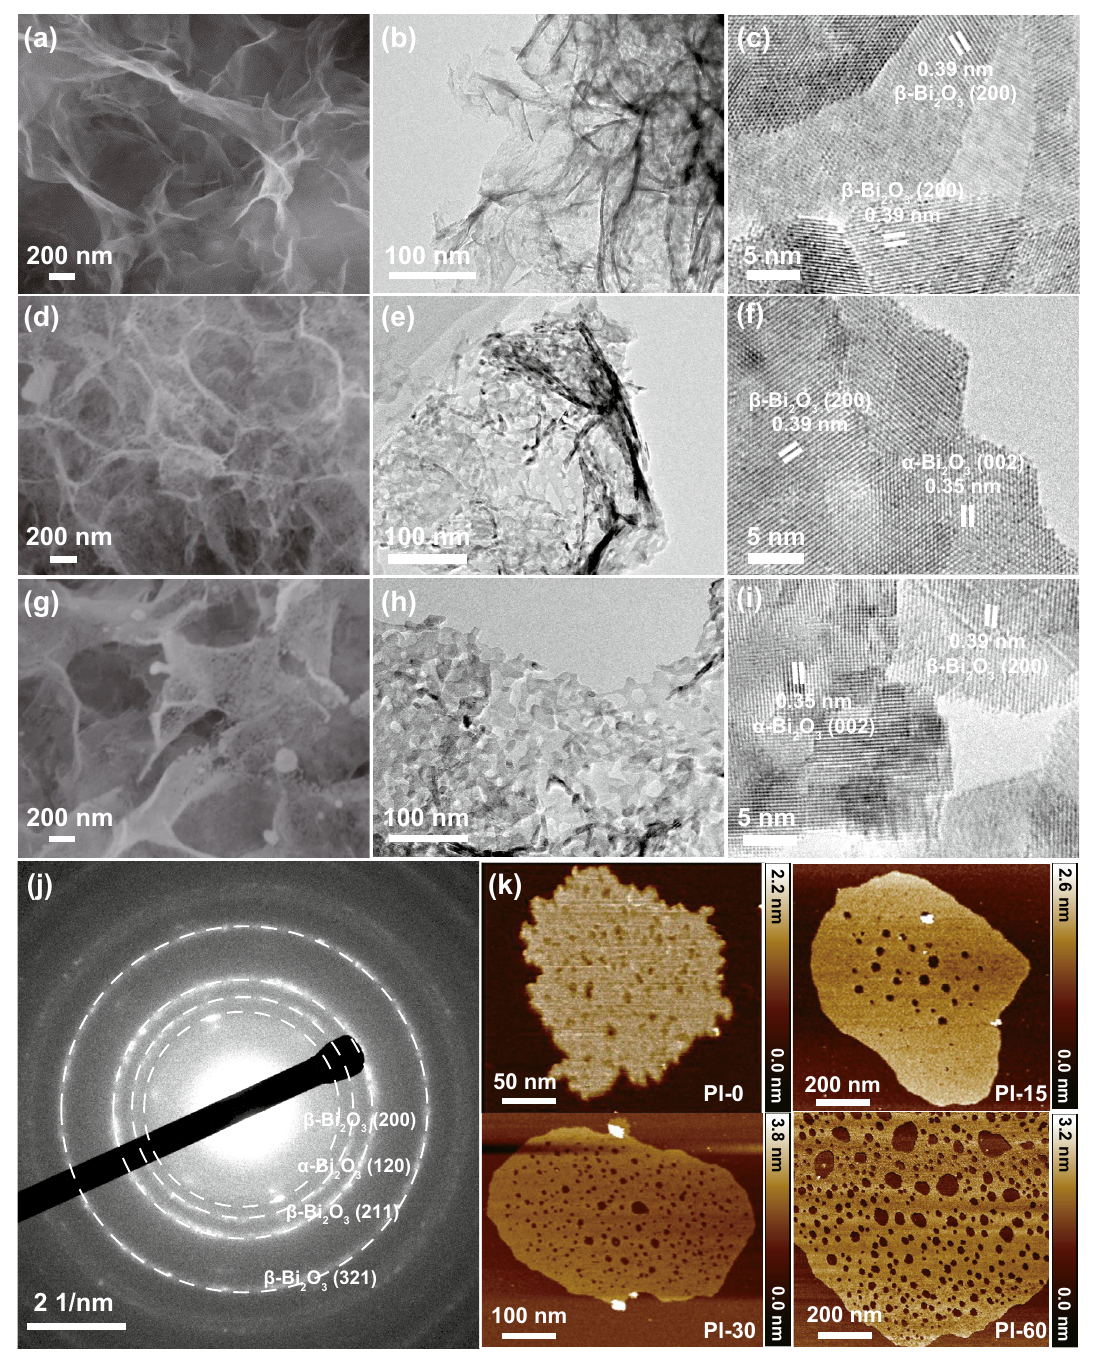
Fig. 2 Morphology evolution of 2D Bi 2 O 3 nanosheets upon plasma irradiations. SEM images ( a , d and g ), low-magnification TEM images ( b , e and h ) and high-resolution TEM images ( c , f and i ) of Bi 2 O 3 before irradiation (Pl-0), irradiated for 15 min (Pl-15), and 30 min (Pl-30), respec- tively. SAED patterns ( j ), AFM images on the changes of thickness and pore sizes with different plasma irradiation durations ( k